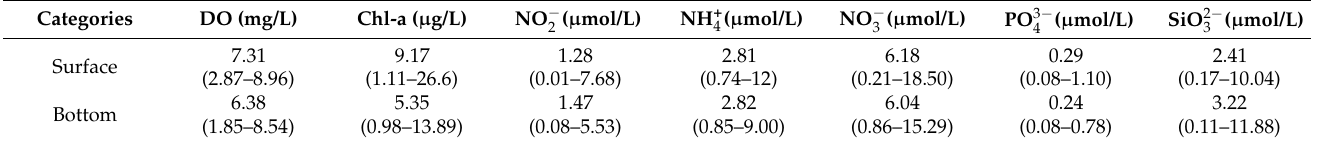
Table 2. Mean values and ranges of relevant biochemical parameters in Bohai Bay.